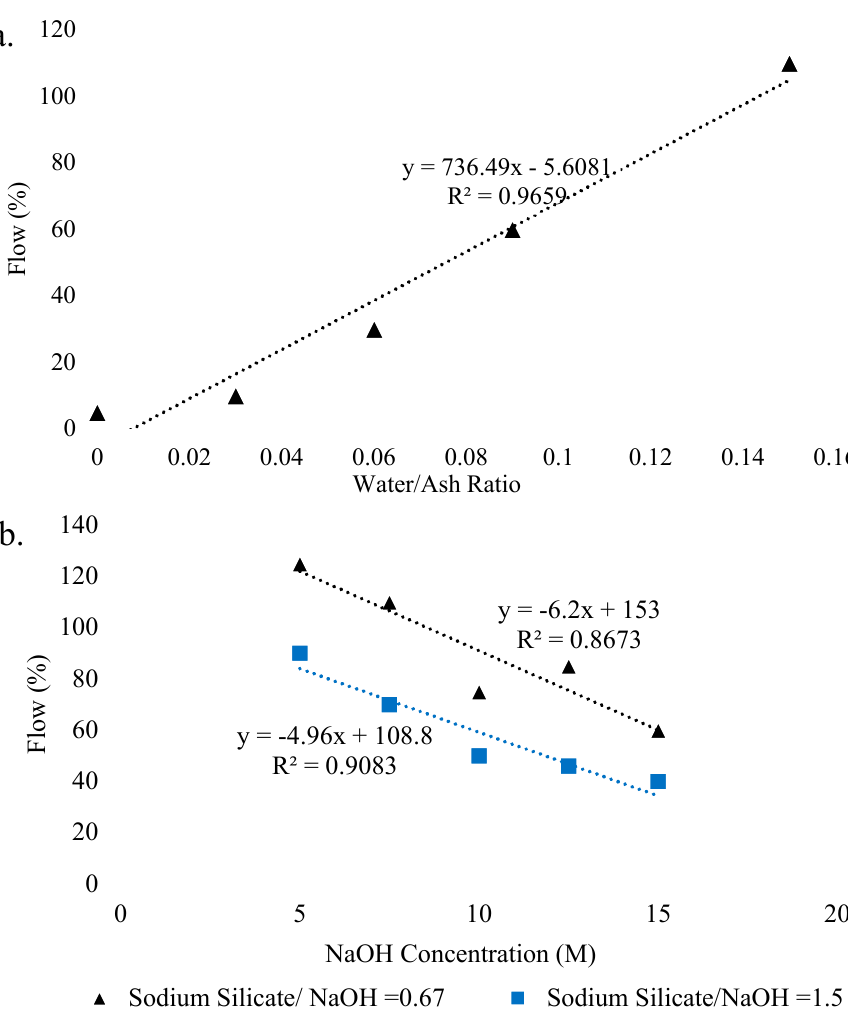
Figure 9. Factors e ff ecting workability. ( a ) E ff ect of water to ash ratio on flow. ( b ) E ff ect of NaOH Figure 9. Factors effecting workability. ( a ) Effect of water to ash ratio on flow. ( b ) Effect of NaOH concentration on flow, adopted from [113]; Elsevier, concentration on flow, adopted from [113]; Elsevier, 2009.